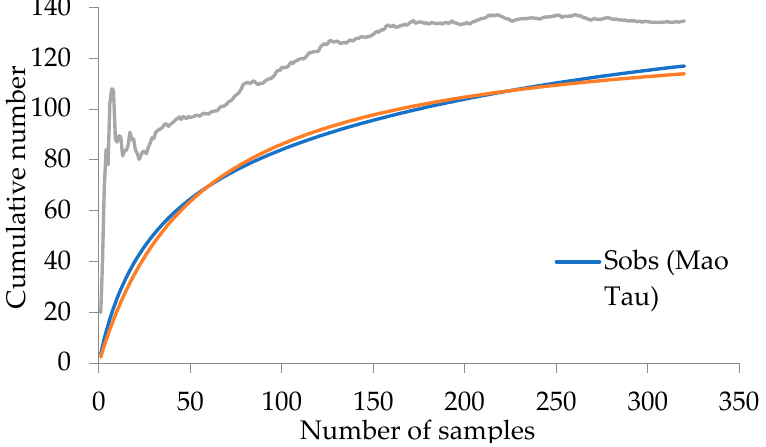
Figure 2. Cluster analysis based on the Jaccard index and UPGMA representing the faunistic rela- tionships between the rivers sampled from the Sierra de Juárez, Oaxaca, Mexico. The richness estimated with the Clench and Chao2 models was very similar (133 and 134 species, respectively), so the 118 collected species represent 88.72% and 88.06% of the theoretical richness, respectively. The data showed a better fit to the Clench model ( R 2 ≥ 0.99, Figure 3), indicating that the inventory was still incomplete (slope greater than 0.01)